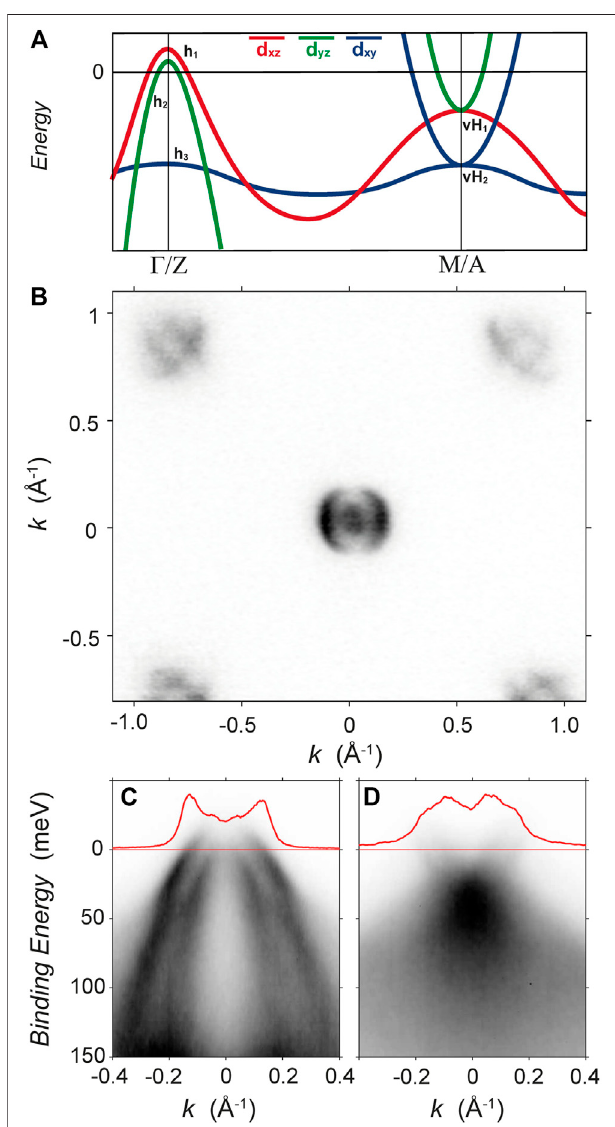
FIGURE 2 | Electronic structure in the tetragonal state of FeSe. (A) Sketch of the low-energy band structure of a typical P 4/ nmm Fe-based superconductoralongthe Γ − M ( k z =0)or Z − A ( k z = π )highsymmetrypoints. The colours indicate the dominant orbital character of the bands. (B) Fermi surface in the tetragonal state measured at 100 K close to k z = π ( h ] = 56 eV). (C) Cut along the Z − A direction (equivalent to Γ − M but at k z = π ) directionfortheholebandsaroundtheZpointforthesamephotonenergy( h ] =56 eV). (D) Cutalongthe Z − A directionfortheelectron bands aroundtheA point. Figures adapted from [29,